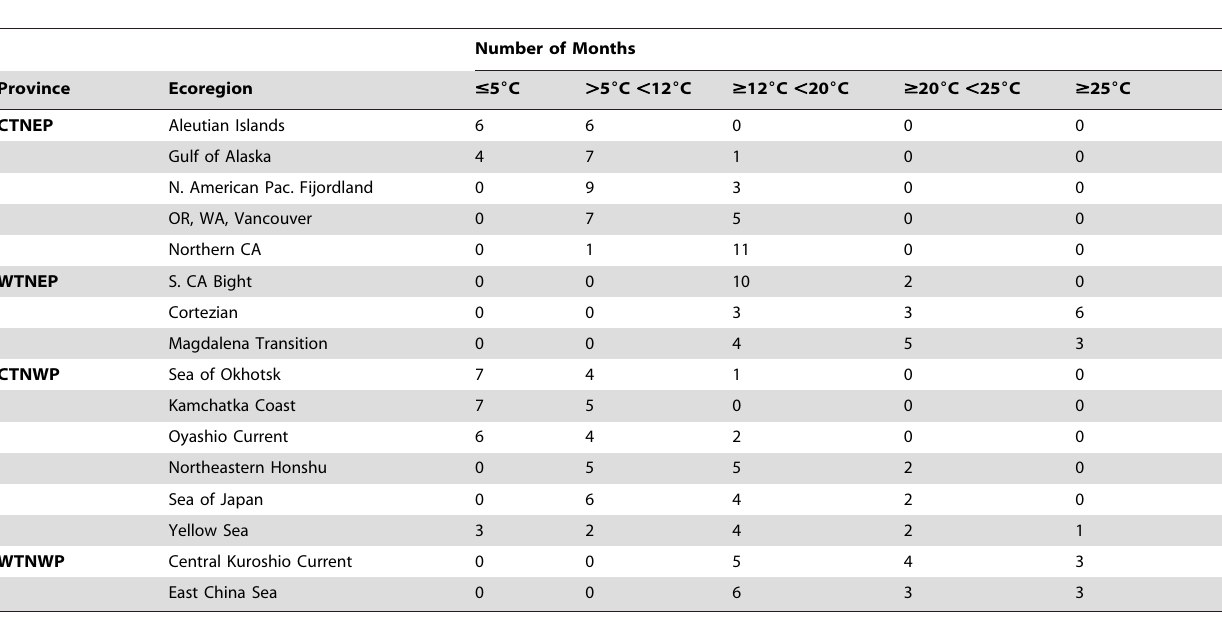
Table 1. Number of months in various temperature intervals for ecoregions of the Temperate North Pacific.*